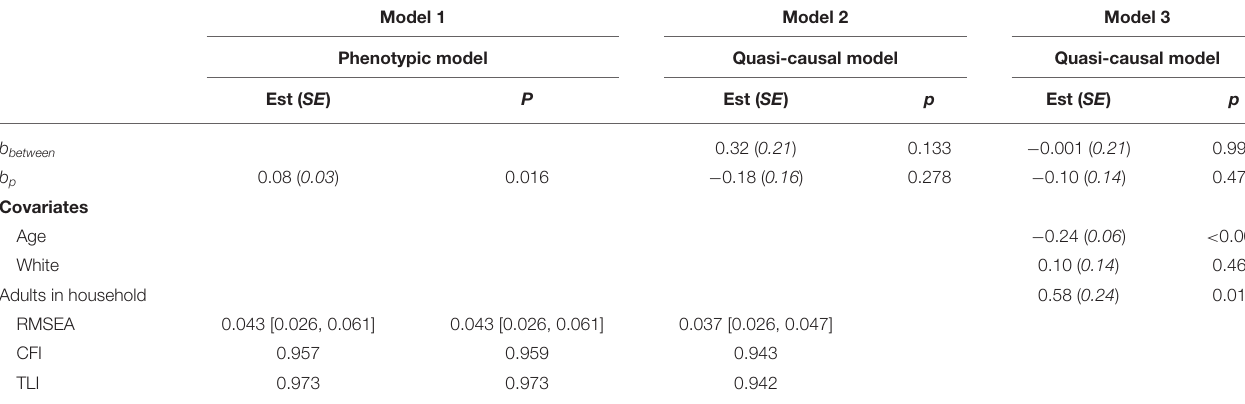
TABLE 6 | Unstandardized parameter estimates for phenotypic and biometric models estimating the effects of children in household on anxiety